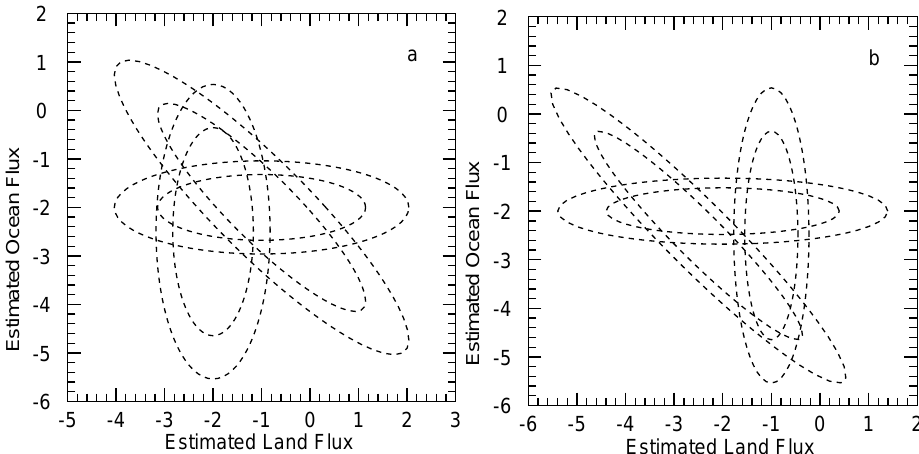
Fig. 3. Schematic of two different possibilities for relations between multiple estimates of carbon budget. (a) : Various classes of estimate give consistent views that can be combined to refine the overall budget. (b) : Various classes of estimate do not give consistent views and imply the need to estimate (and seek to identify) a residual process.